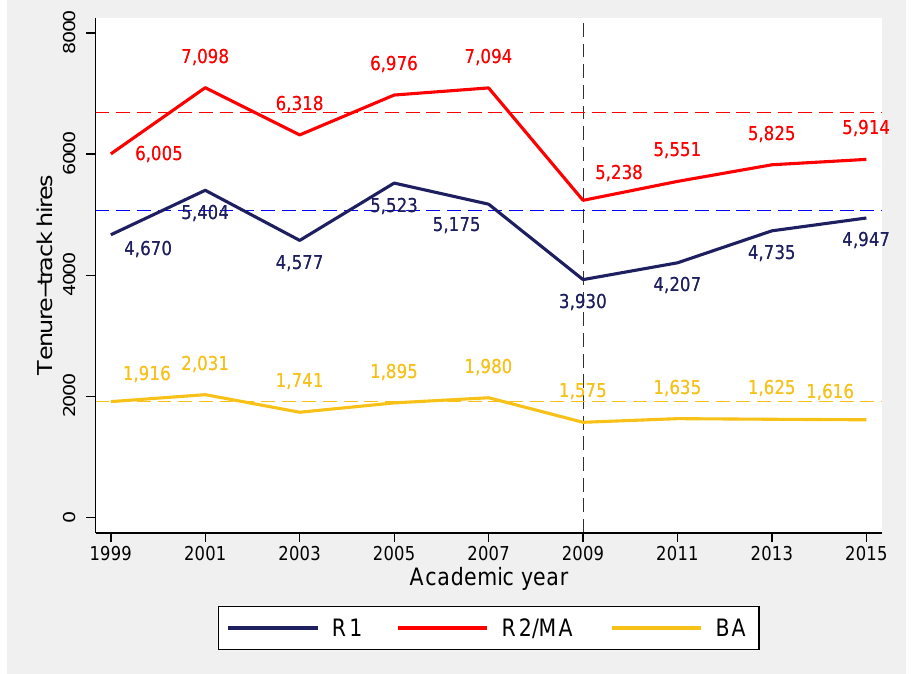
Figure 2: Tenure-track hires by Carnegie group. Dotted horizontal lines denote pre- recession (1999 to 2007) averages. Dotted vertical line denotes the year 2009, the first year that we see a contraction in new tenure-track hiring due to the Great Recession. men and women declined by 35 percent. If trends had continued, Asian American women and men would have risen by 12 percent and seven percent; instead they declined by 23 percent and 35 percent, respectively. White women would have risen by one percent, and white men would have declined by three percent; instead both declined by about 31